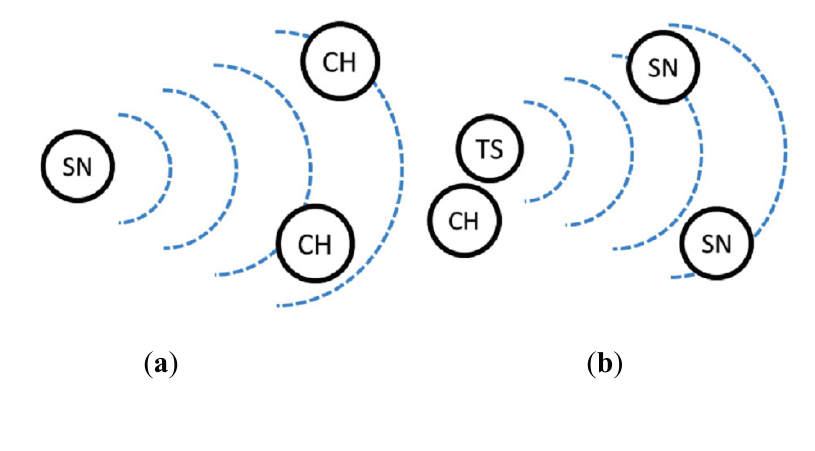
Figure 2. Cluster formation phase. ( a ) Sub-phase 1: cluster head discovery, when a sensor node tries to locate cluster heads. ( b ) Sub-phase 2: cluster member invitation, when a cluster head tries to invite new cluster members with the help of a temporary support